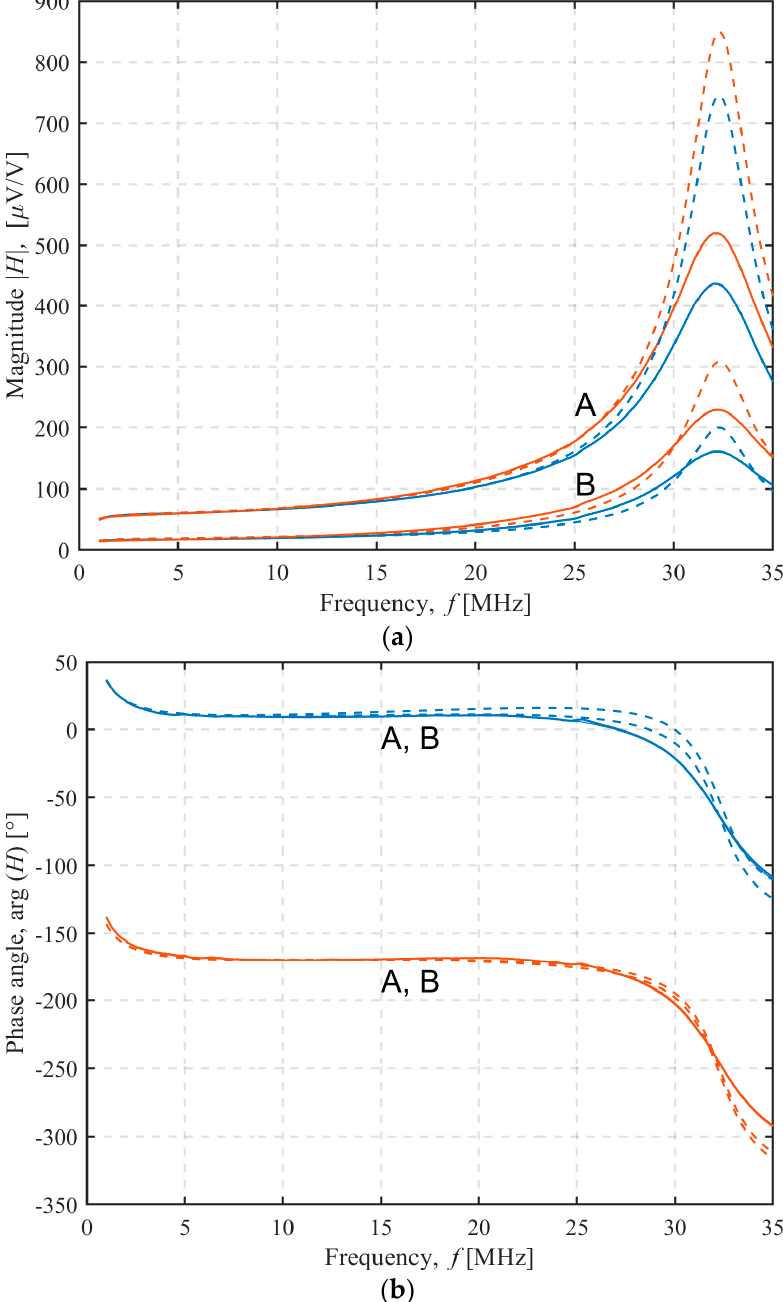
Figure 7. TX C-6/RX C-6 configuration: ( a ) magnitude and ( b ) phase characteristics of the sensor. Measurement (full line) and model results (dashed lined). Transmitter orientation up (blue line) or down (red line). Transmitter–receiver separation 27 cm ( A ) or 37 cm ( B ).